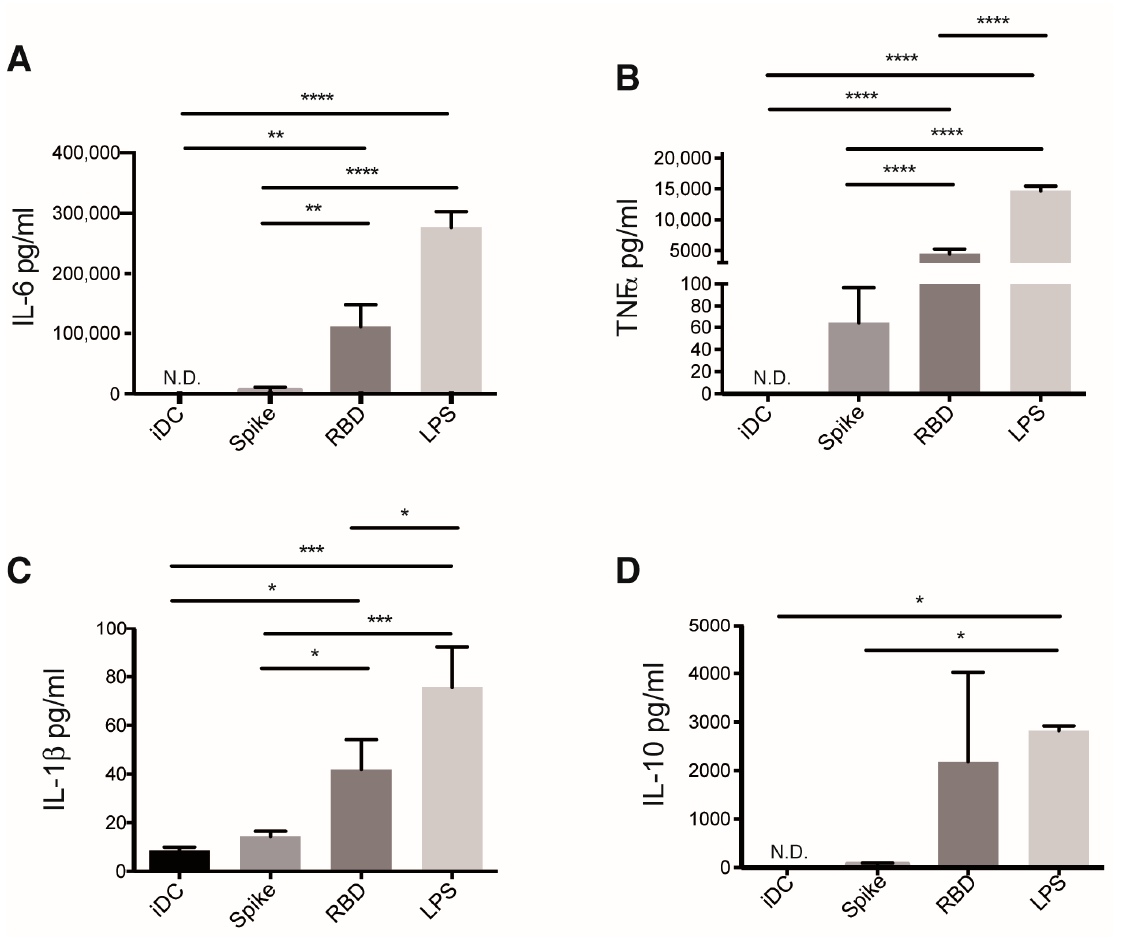
Figure 4. Spike and RBD of SARS-CoV-2 promotes proinflammatory cytokine production by DCs. Cells were incubated with the indicated stimulus, and the concentration of different cytokines secreted after 24 h was measured in supernatants by ELISA. IL-6 ( A ), TNF α ( B ), IL-1 β ( C ), and IL-10 ( D ). The graphs show mean ± SEM of two independent experiments; N.D., not detected; multiple comparisons of the values of different treatments by using One-way ANOVA test. n = 4 donors in each case. Only significant differences are indicated. * p < 0.05, ** p < 0.02, *** p < 0.01, **** p <